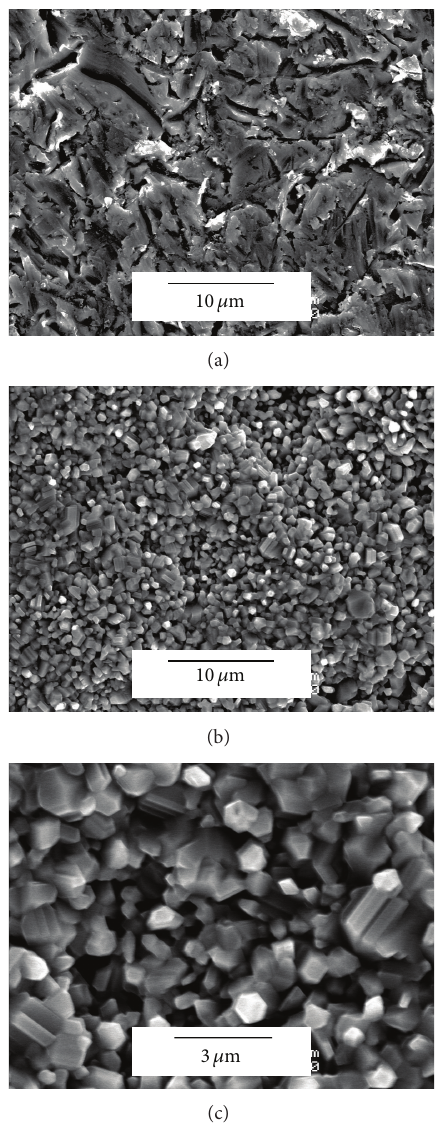
Figure 4: SEM images of CP Ti surfaces. (a) As-prepared, (b)-(c) heated at 1000 ∘ C for 1hr, and (c) magnified image of